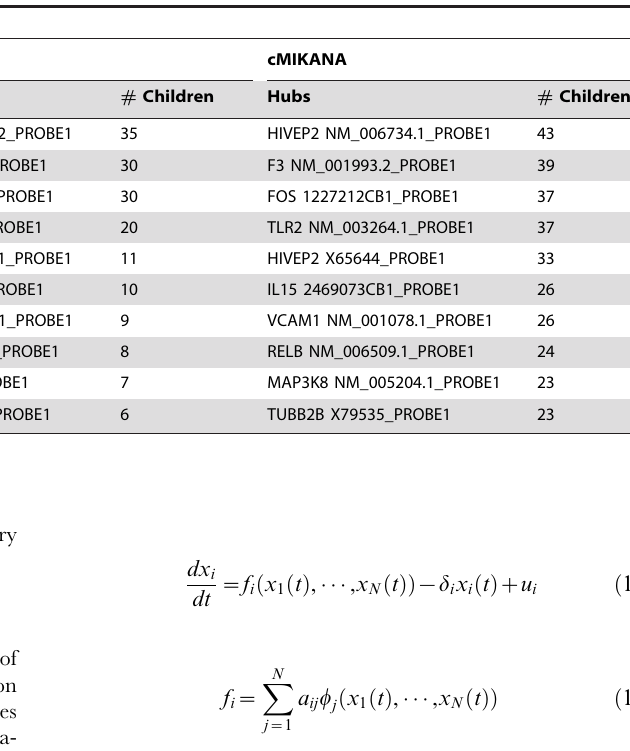
Table 2. Top 10 hubs from the ssMIKANA, tsMIKANA and cMIKANA network models respectively, reconstructed from endothelial